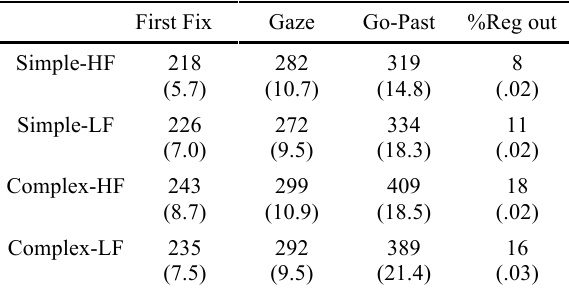
Average eye movement measures on Region 1, the critical verb, in milliseconds (standard errors in